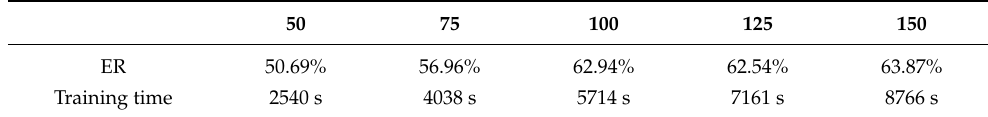
Table 5. Experimental results of parameter selection for maximum step